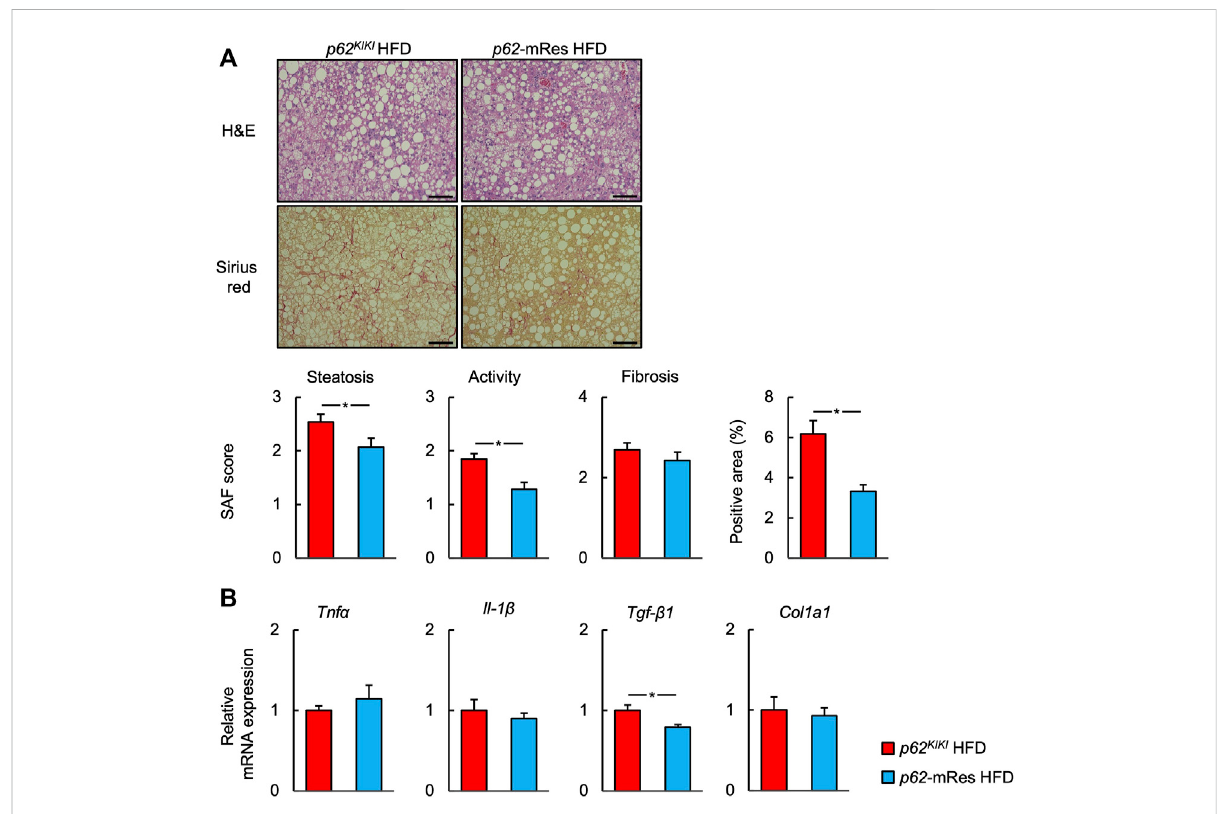
p62 expression in muscle retards the progression of NASH. (A) Representative hematoxylin and eosin (H&E) and Sirius red-stained sections of liverfrom25-week-old p62 KI/KI and p62 -mResmicefedanHFD.Scalebarsrepresent100 μ m.Thesteatosis,activity,and fi brosis(SAF)scoreandarea positive for Siriusredstaining ( n =13 – 14/group). (B) mRNA expression ofproin fl ammatorycytokines( Tnf α and Il-1 β )and fi brosis-relatedgenes ( Tgf- β 1 , and Col1a1 ) ( n = 8/group). Values are mean ± SEM. * p < 0.05 (unpaired t